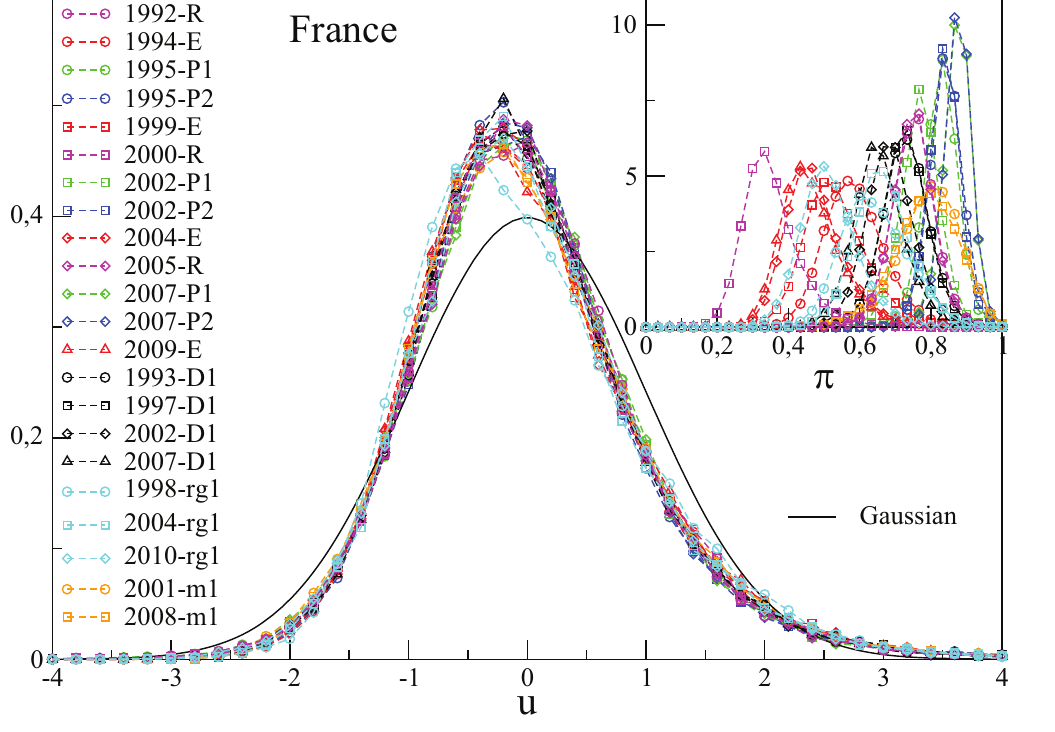
Figure 1. Probability distribution of the rescaled variable u over all communes for France. A standardized Gaussian is also shown. The inset similarly shows the probability distribution of the usual turnout rate p . We use the same symbols and color codes for the French elections throughout this paper.